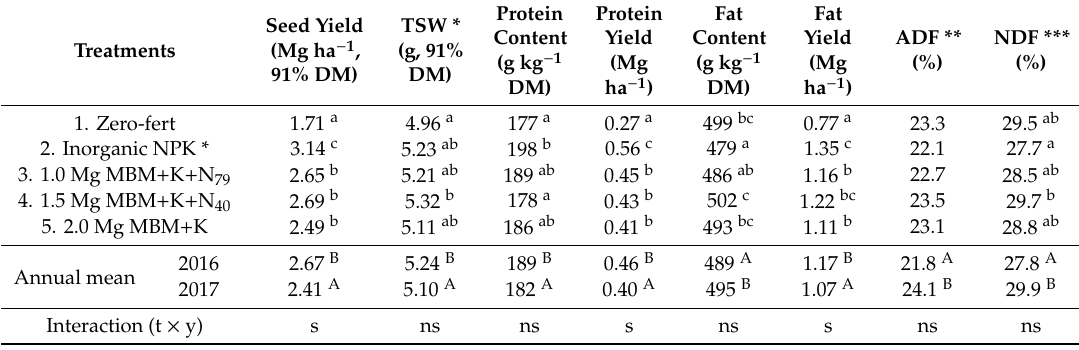
Table 2. Seed yield and quality of winter oilseed